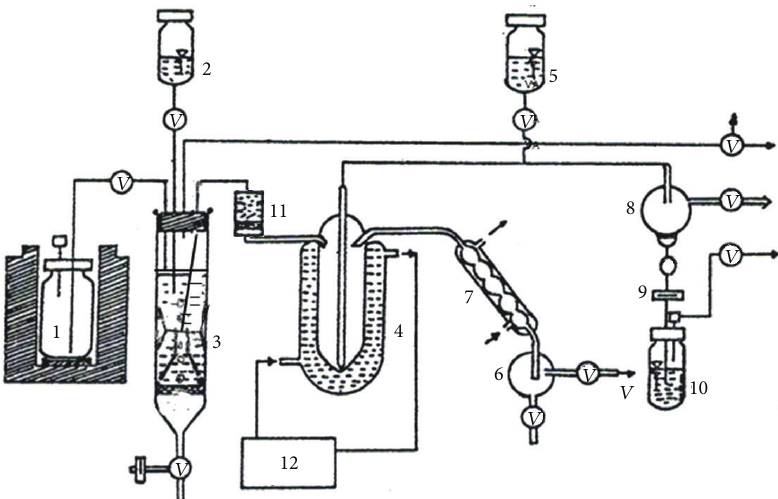
Figure 4: Diagram of MEK extraction-based 99 Mo / 99 m Tc generator [60]. 1: alkaline 99 Mo-molybdate solution; 2: MEK solvent; 3: